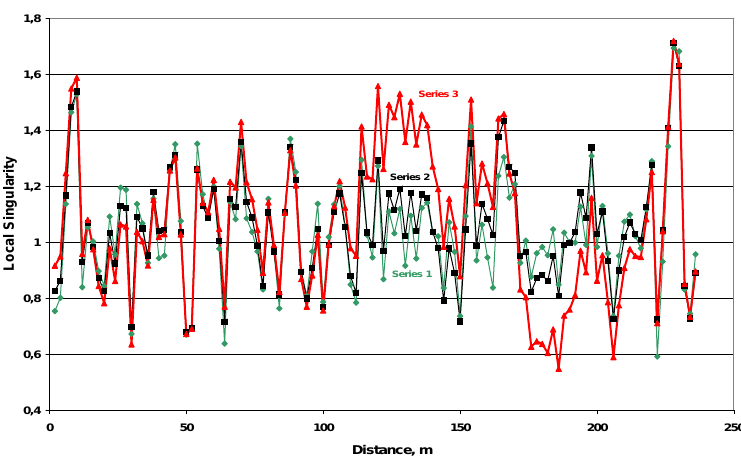
Fig. 20. Estimated singularities for iterative process with k = 1 (green diamonds of Series 1), k = 5 (black squares of Series 2)and k = 1000 (red triangles of Series 3). Final singularities ( k = 1000) differ only slightly from local singularities estimated by means of Eq. (17) ( k = 1). Except near beginning and end (locations 1–4 and 115–118) results are identical to estimates of Chen et al. (2007). For k = 1000, original iterative process of Fig. 18 and modified process of Fig. 19 gave the same final singularities.